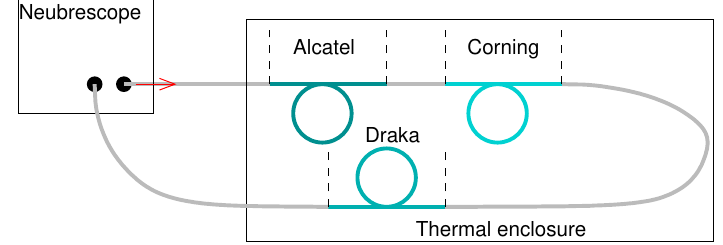
Figure 4. Assembly diagram of bare